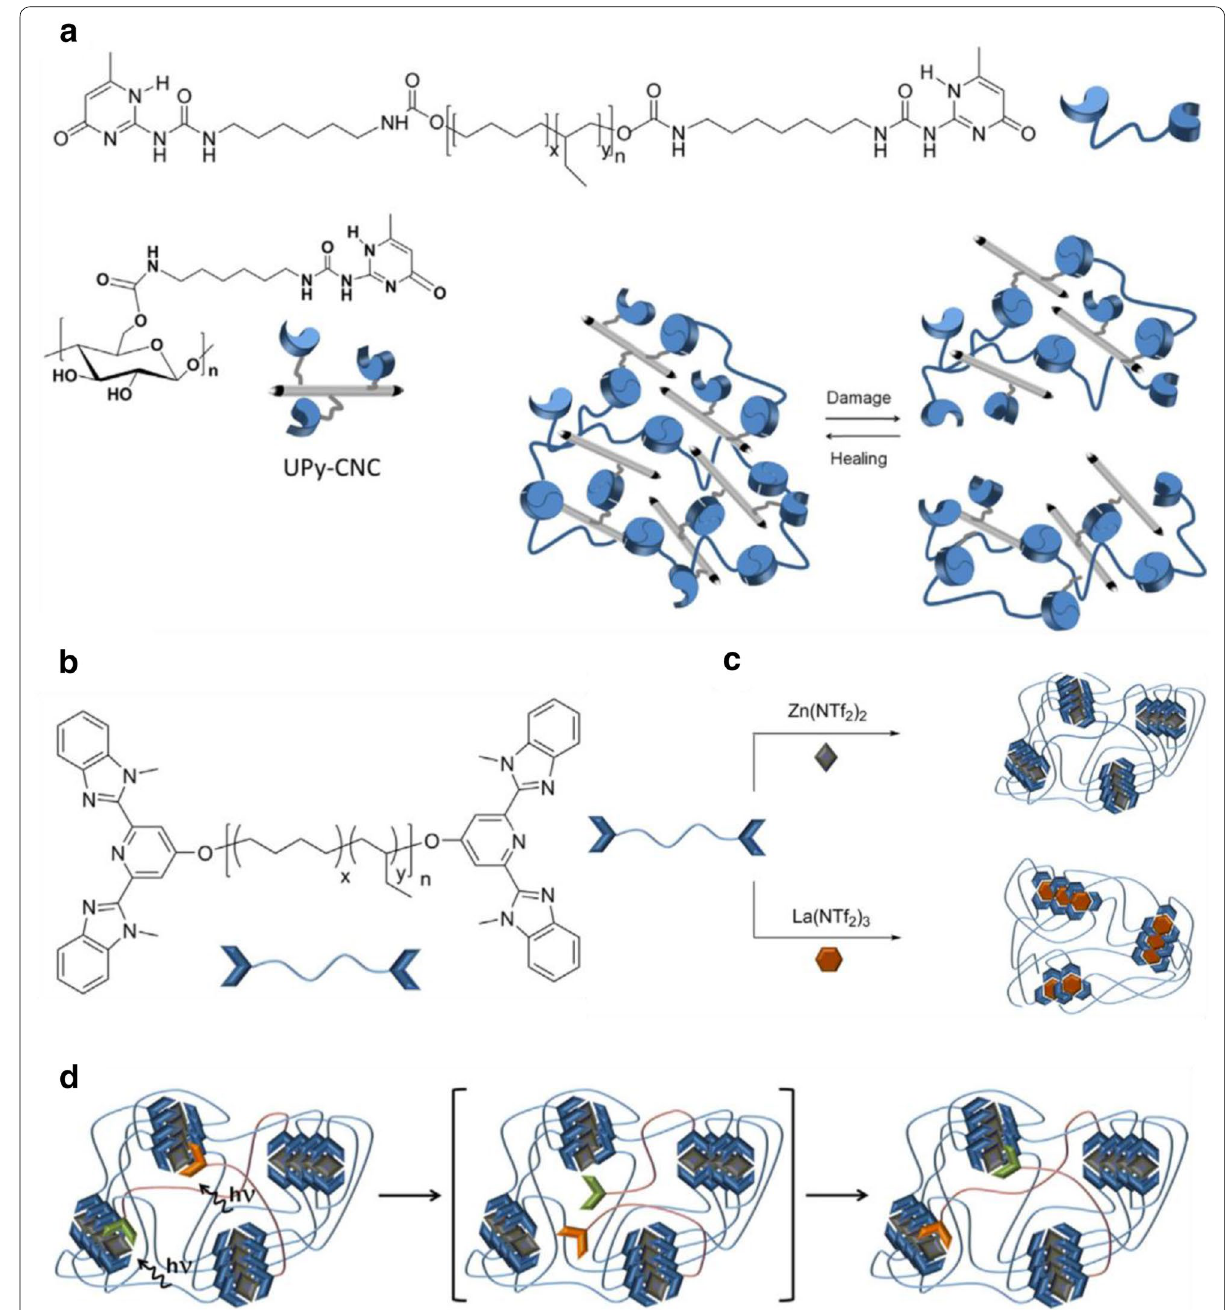
Fig. 9 a Chemical structures and schematic illustration of CNC functionalized self-healing of UPy nanocomposites based on telechelic PEB building blocks. b , c Chemical structure of the metallopolymers via assembly of Mebip end-capped telechelic poly(ethylene-co-butylene) with Zn(NTf 2 ) 2 or Eu(NTf 2 ) 3 . d Schematic representation of the UV-light triggered metallosupramolecular nanocomposites (figures reproduced with permission from: a Ref. [75], ©2013 ACS; b – d Ref. [92], ©2011 NPG; b – d Ref. [93], ©2013